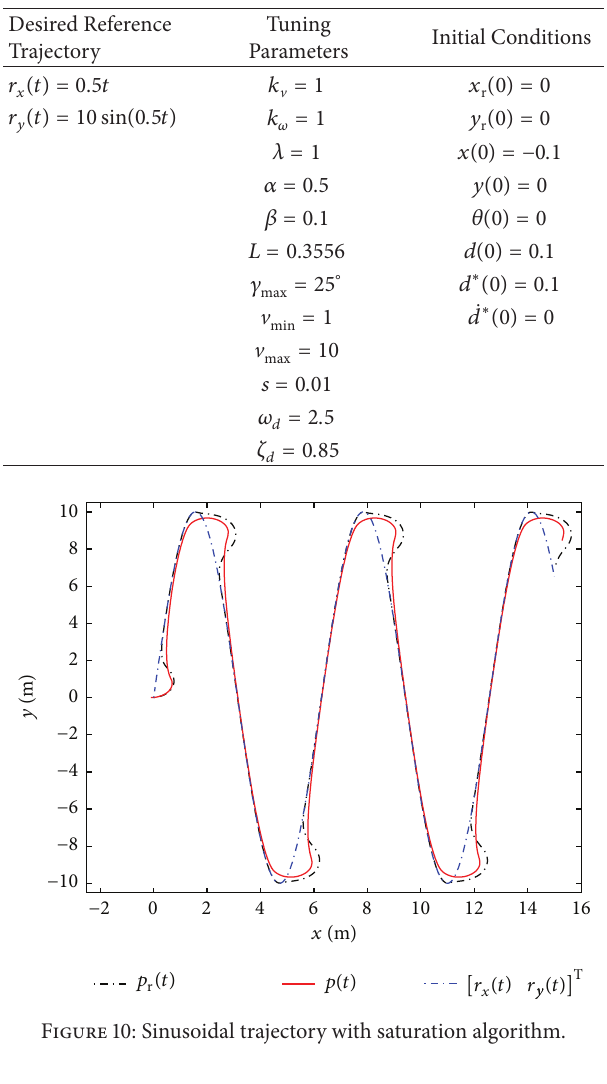
Table 2: Parameters for simulation with saturation.